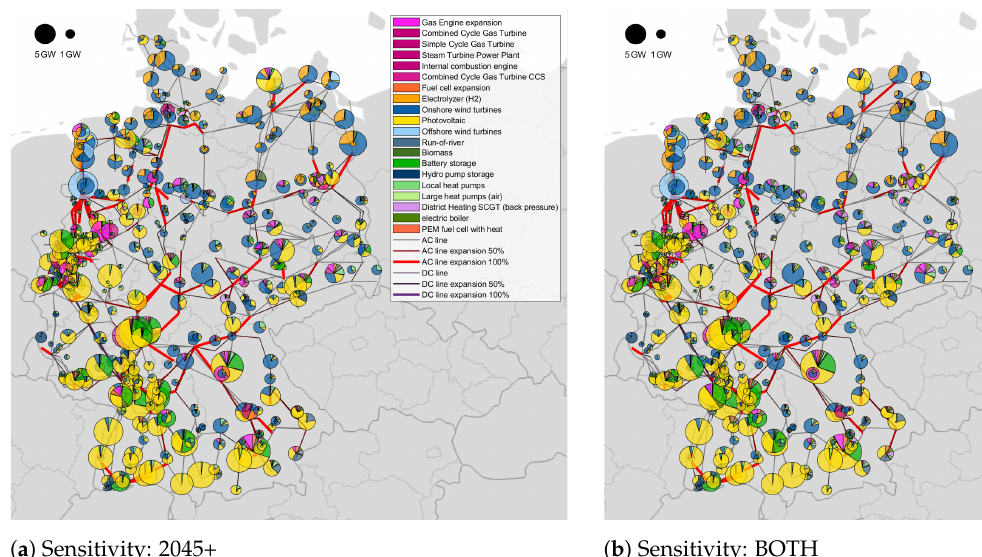
Figure 11. The results of electric technology expansion in two sensitivites only vary slightly and must be compared in greater detail.